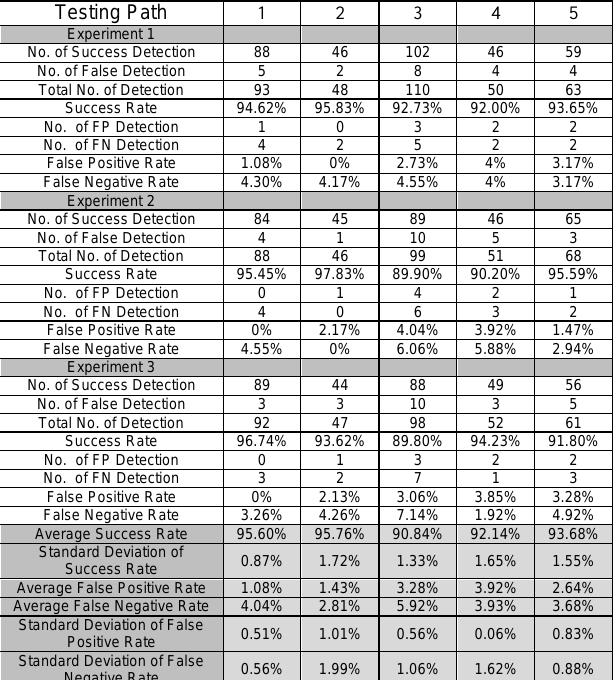
Table 2. Conclusive Results for Testing Path 1 to 5.